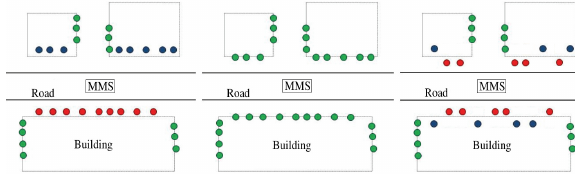
Figure 2. Illustration of the influence of positioning and map- ping (relative) accuracy on the absolute accuracy of a MMS: low pos. + high map. accuracy (left), high pos. + high map. accuracy (centre) and high pos. + low map. accuracy